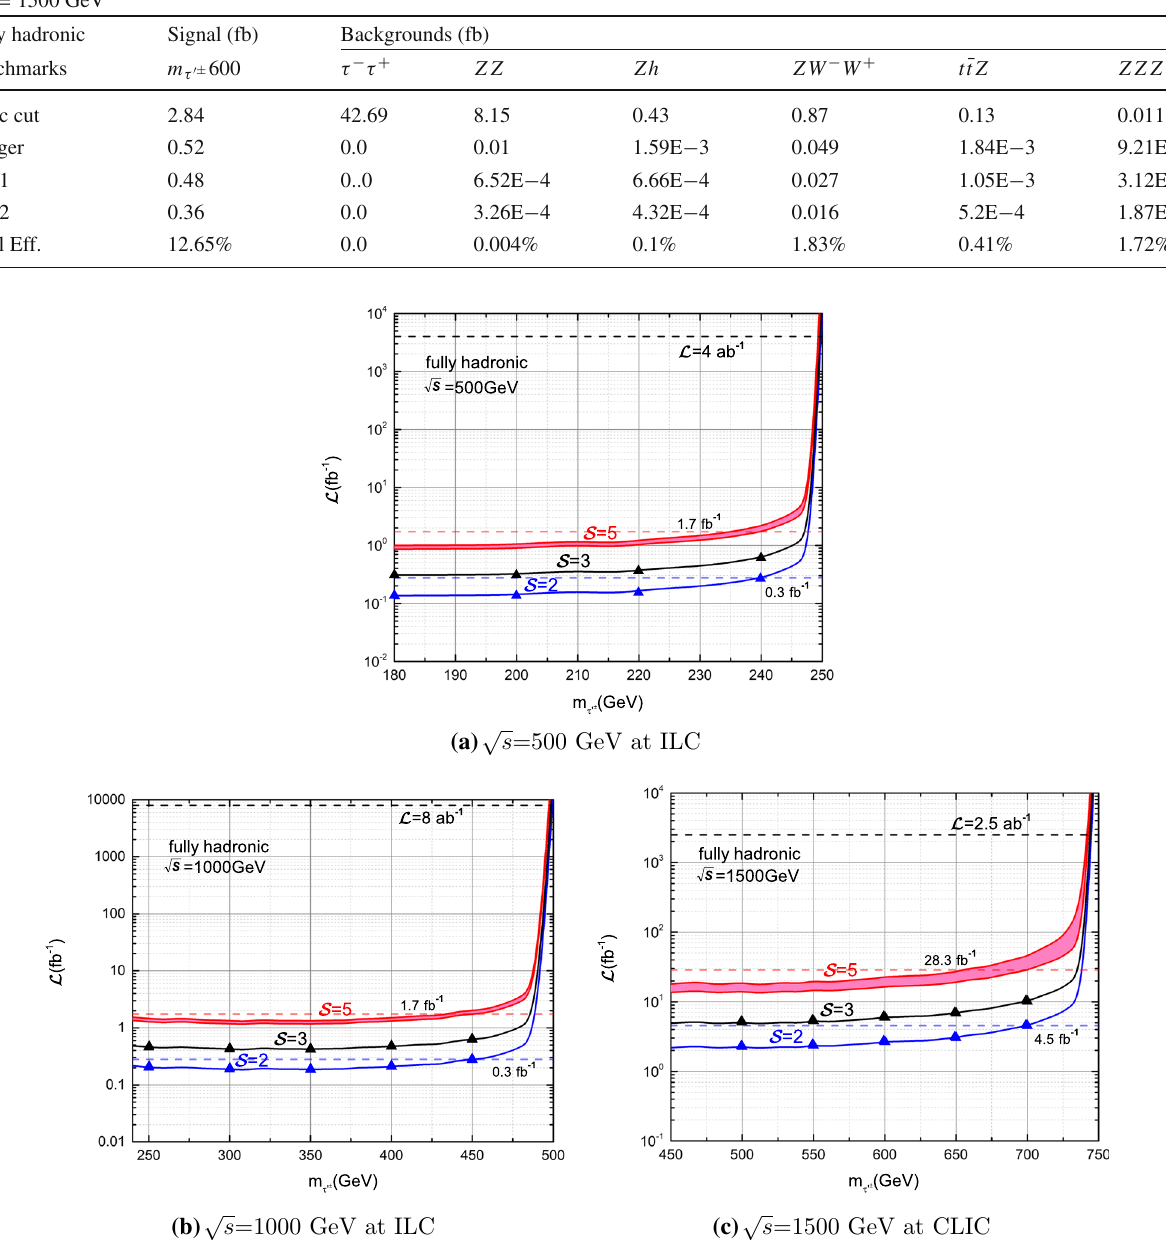
Fig. 10 Same as Fig. 8, but for the fully hadronic channel and the surrounding red band corresponds to the significance considering the systematic uncertainties σ B = 0 . 5 ∗